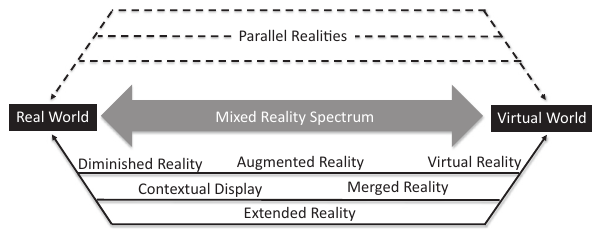
Figure 2: Mixed-reality spectrum